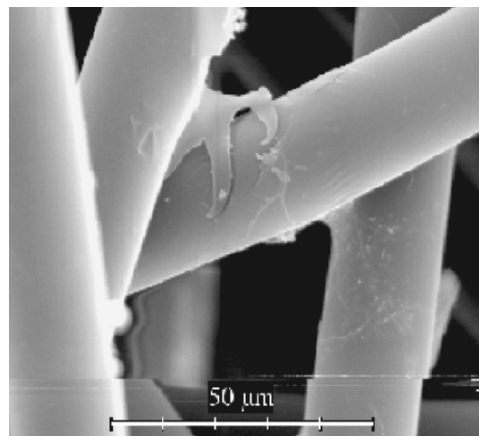
Figure 7: SEM image of chitosan coated PP fibres after five standard laundering